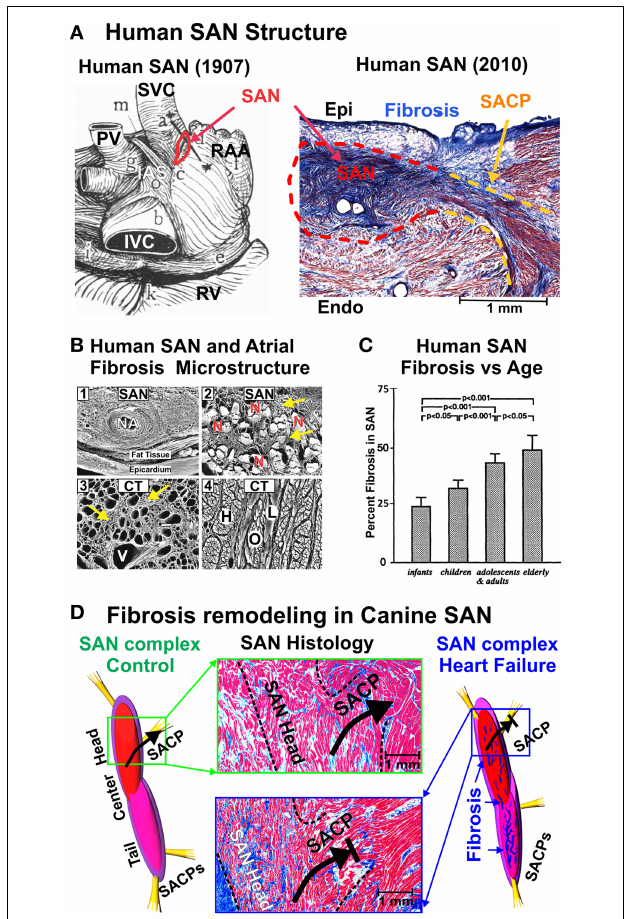
FIGURE 1 | (A) Left: Drawing of the posterior human atrial anatomy from (Keith and Flack, 1907), with SAN outlined in red. Right: Histological cross section of the SAN (red outline) connected to the atria by a SACP (yellow outline). The SAN is seen to be isolated from the atria by sup-epicardial fat and connective tissue. Modified from Fedorov et al. (2010b, 2012) with permission. (B) 1—Scanning electron micrograph of the SAN and nodal artery (NA) of a cross section through the CT after digestion of the nodal cells. The collagenous sheaths of endomysial fibrosis formed a complex network in the gaps between the nodal cells, whereas occasional perimysial septums were seen between them. 2—Scanning electron micrograph of non-macerated SAN cells (N), which are encased in dense and coarse endomysial sheaths (yellow arrows) in a specimen from a 75 year old. 3—Scanning electron micrograph of a cross section through the CT, after digestion, from a specimen of 70 years shows a diffuse notable excess of endomysial sheaths (yellow arrows) indicating focal interstitial reactive fibrosis. Vascular space (V) corresponds to a coronary vein. 4—Scanning electron micrograph of non-macerated cross section through the body of the CT shows mainly longitudinal fibers (H) with intermingling oblique (O) or lateral (L) fibers. From Sanchez-Quintana et al. (2002) with permission. (C) Graph showing percentage of fibrous connective tissue volume to the total SAN volume, mean value, and standard deviation. From Shiraishi et al. (1992); used with permission. (D) Fibrosis in the SAN is increased in HF vs. control dog. Left: A structural model of the control canine SAN complex and SACPs. Middle: histological sections showing upregulated fibrotic and fatty content in SAN complex (black outline) and SACP in HF (bottom, blue box) compared to control (top, green box).